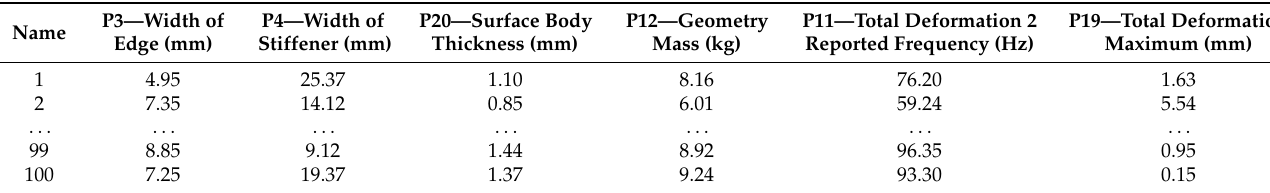
Table 3. Generation point of test design.